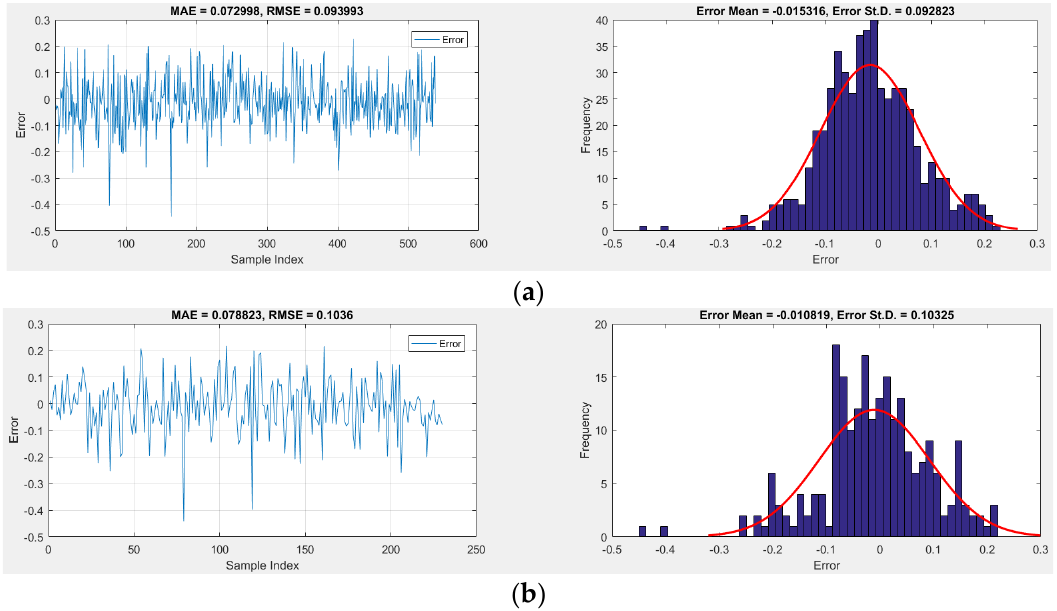
Figure 7. Frequency and minimum value of errors in HHO − ANFIS − 200 best fit structure. ( a ) Train- ing dataset. ( b ) Testing dataset.